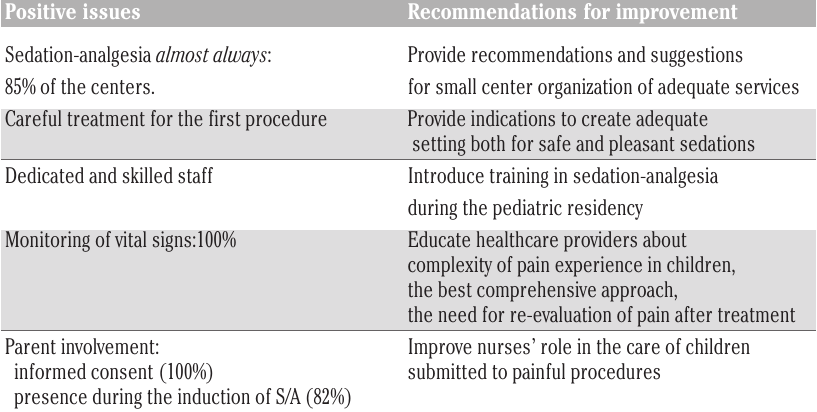
Table 2. Good aspects in procedural pain management emerging from our survey and recommendations for